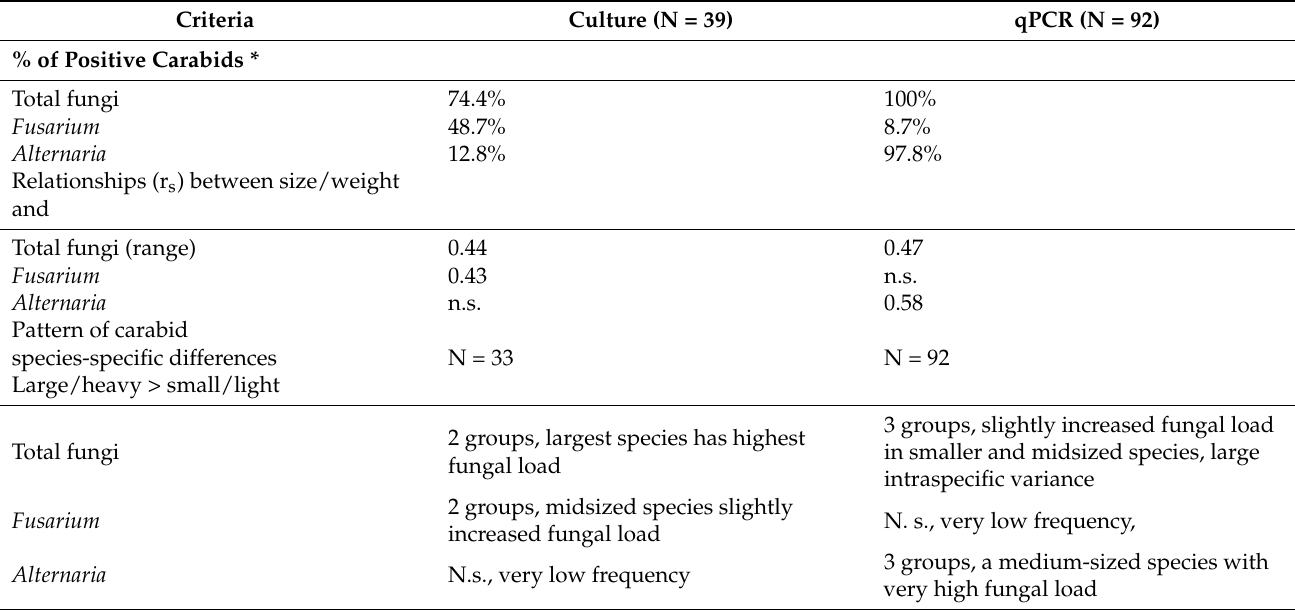
Table 4. Synthesis of the most relevant